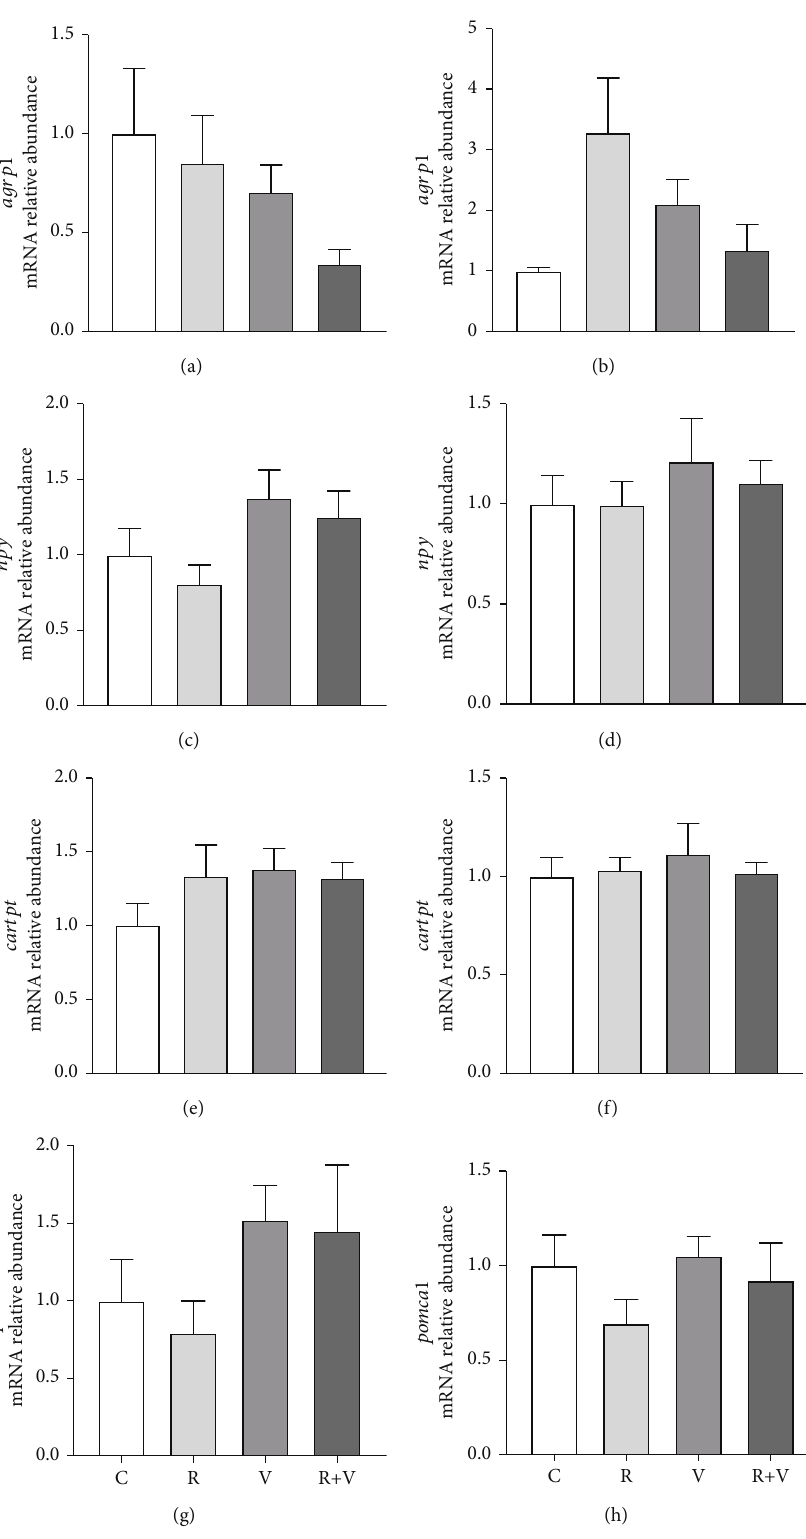
Figure 4: mRNA relative abundance of the agrp1 (a, b), npy (c, d), cartpt (e, f), and pomca1 (g, h) in the hypothalamus (a, c, e, g) and telencephalon (b, d, f, h) of rainbow trout 6 h after intracerebroventricular injection of 1 μ L · 100g -1 body mass of a solution containing saline and dimethyl sulfoxide (DMSO) alone (control) or containing 20mM rapamycin (R), 80mM of L-valine (V), or rapamycin with valine (R+V). Values (referred to as the control group) are mean ± SEM of N = 6 fi sh per treatment and were previously normalized by mRNA abundance of actb and eef1a1